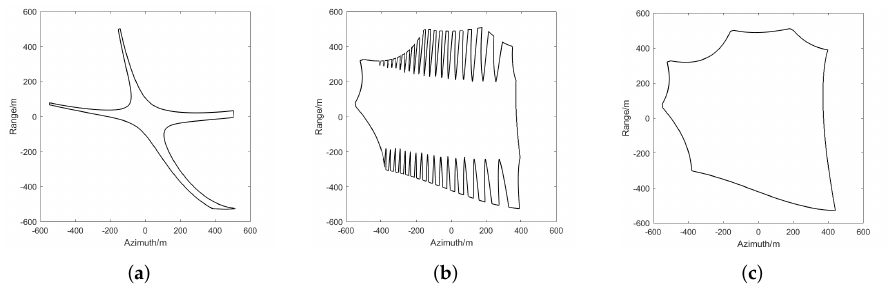
Figure 16. Swath limits for ( a ) zero-layer ML-OSA, ( b ) one-layer ML-OSA and ( c ) two-layer ML-OSA,